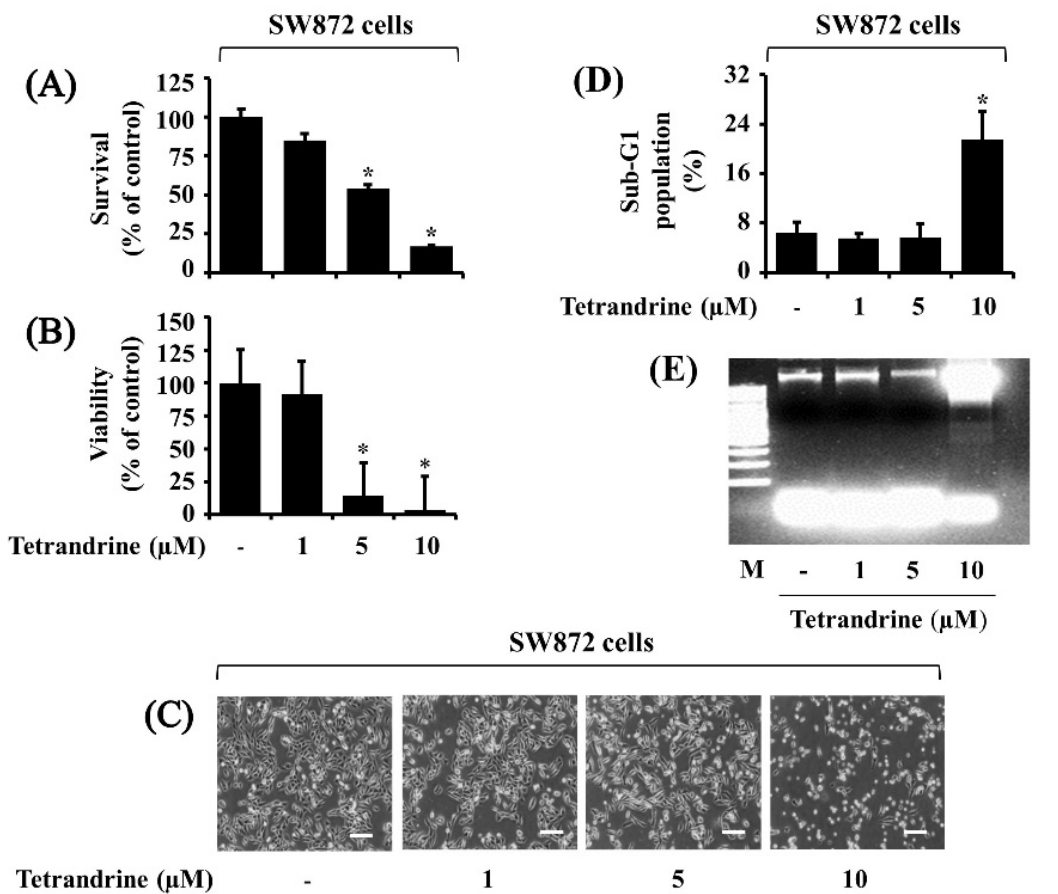
Figure 1. Effects of tetrandrine on the survival, viability, and apoptosis of SW872 cells. ( A – E ) SW872 cells were treated with vehicle control (0.1% DMSO) or tetrandrine at different concentrations (1, 5, or 10 µ M) for 24 h. The number of surviving cells was analyzed by cell count assay ( A ). The cell count assay was carried out in triplicate. Data are expressed as mean ± SE of three individual exper- iments. * p < 0.05 was compared to the value of tetrandrine-free control at the indicated concentra- tions. The viability of cells was analyzed by the MTS assay ( B ). The MTS assay was carried out in triplicate. Data are expressed as mean ± SE of three individual experiments. * p < 0.05 was compared to the value of tetrandrine-free control at the indicated concentrations. The morphological image of the conditioned cells was captured by a phase-contrast microscope (100×, scale bar = 12.5 μ m). Each image is the representative of three independent experiments ( C ). SW872 cells were treated with vehicle control (0.1% DMSO) or tetrandrine at different concentrations (1, 5 or 10 μ M) for 24 h, and the conditioned cells were stained with propidium iodide (PI). The apoptotic cells with the sub-G1 phase were detected by flow cytometry analysis ( D ). SW872 cells were treated with vehicle control (0.1% DMSO) or tetrandrine at different concentrations (1, 5, or 10 μ M) for 24 h. Genomic DNA from the conditioned cells was extracted and analyzed by 1% agarose gel electrophoresis. M, a DNA size marker ( E ).